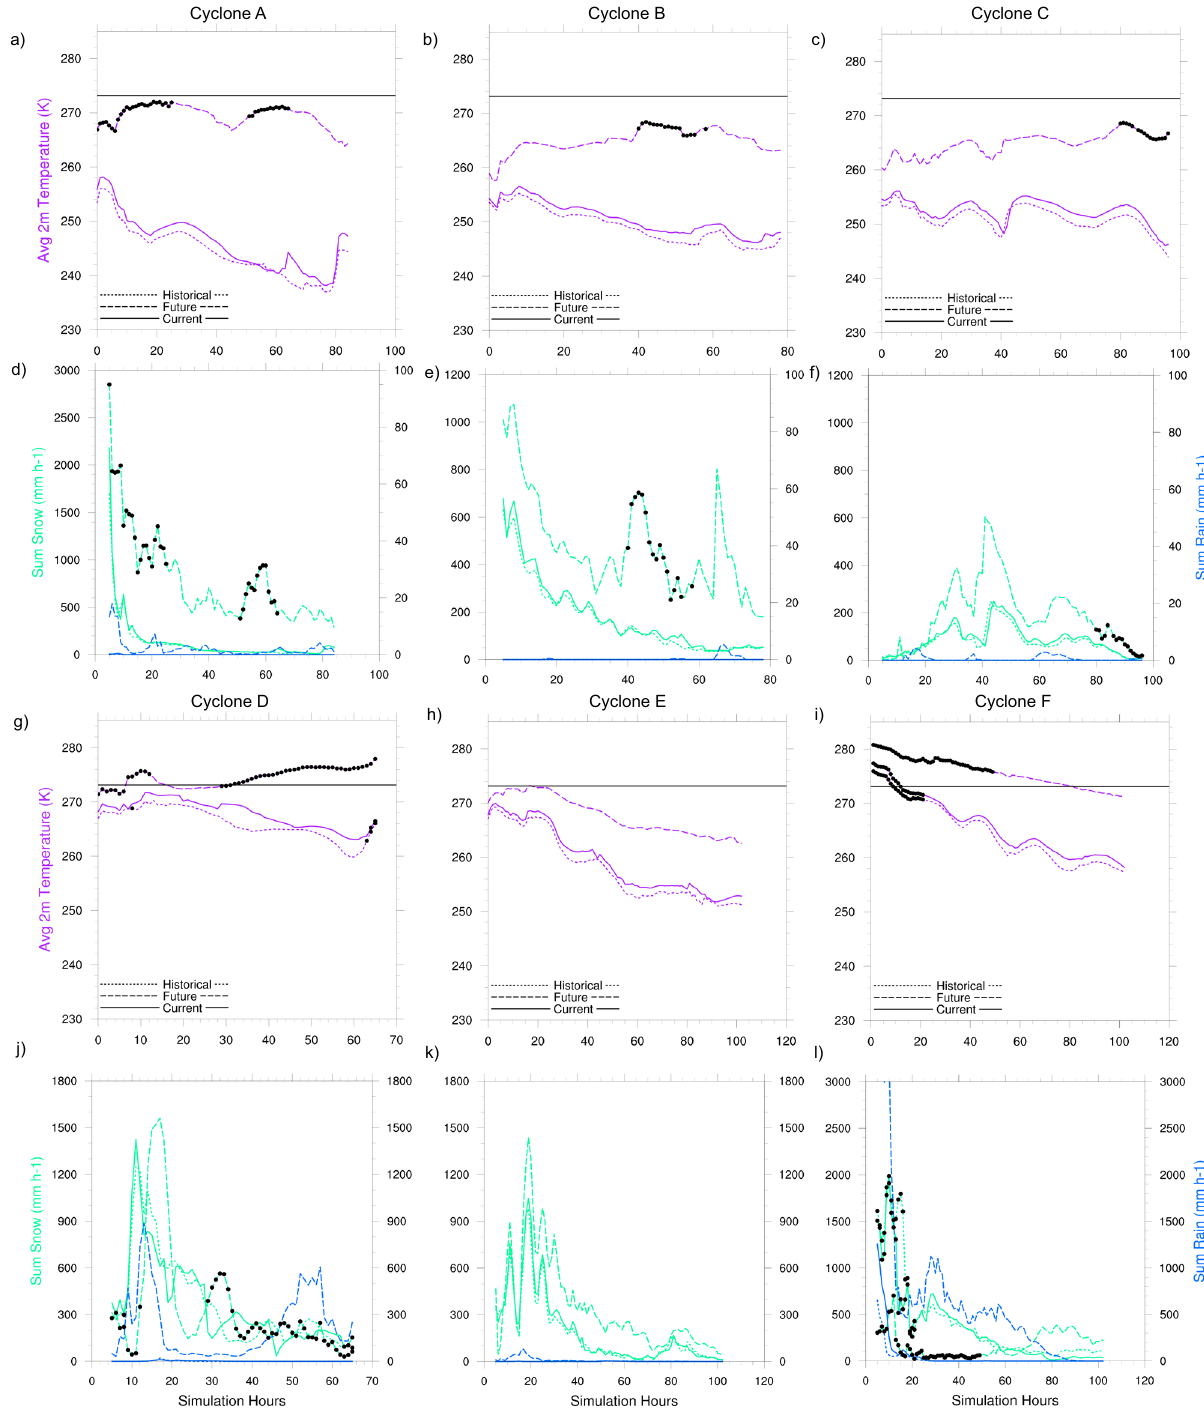
Fig. 4 | The evolution of near-surface air temperature and precipitation (snow and rain) rates over cyclone lifecycles in contrasting climates. The hourly cyclonenearsurface(2m)temperature(K)averagedandsnowfallandrainfallrates (mmh − 1 ) summed over a 200km 2 area around the cyclone center throughout the simulations for March Cyclones A – C (panels a – f ) and April Cyclones D – F